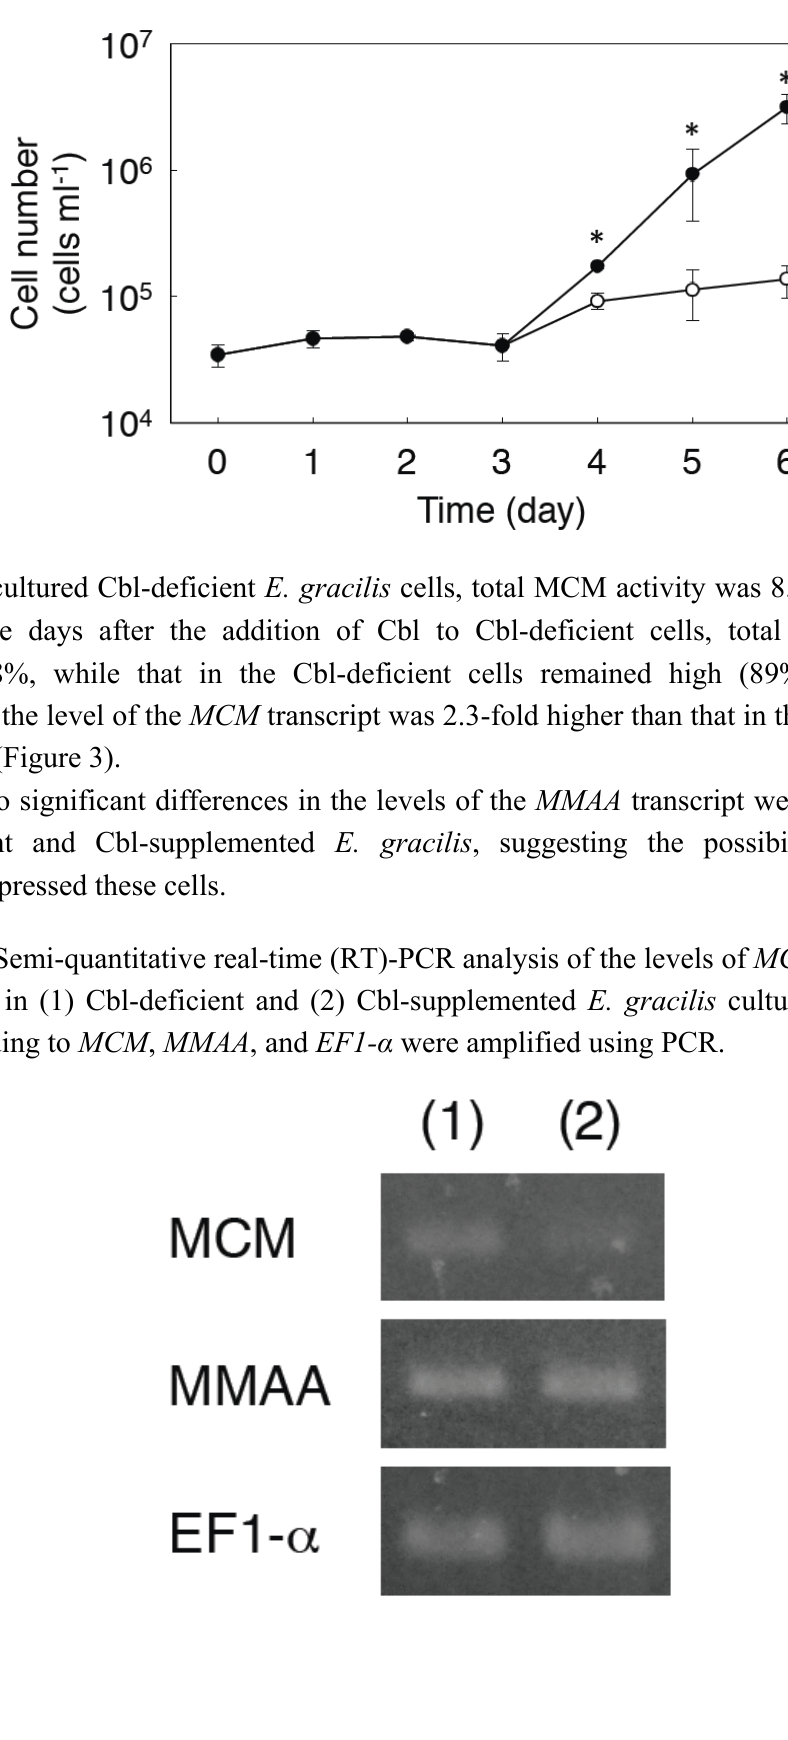
Figure 2. Effect of the addition of CNCbl on the growth of Cbl-deficient E. gracilis cells. Open circles are Cbl-deficient cells. Closed circles are Cbl-supplemented cells. The data are the mean value ± SD of three individual experiments. Asterisks indicate that the mean values are significantly different compared with those of Cbl-deficient E. gracilis cells ( p < 0.05).